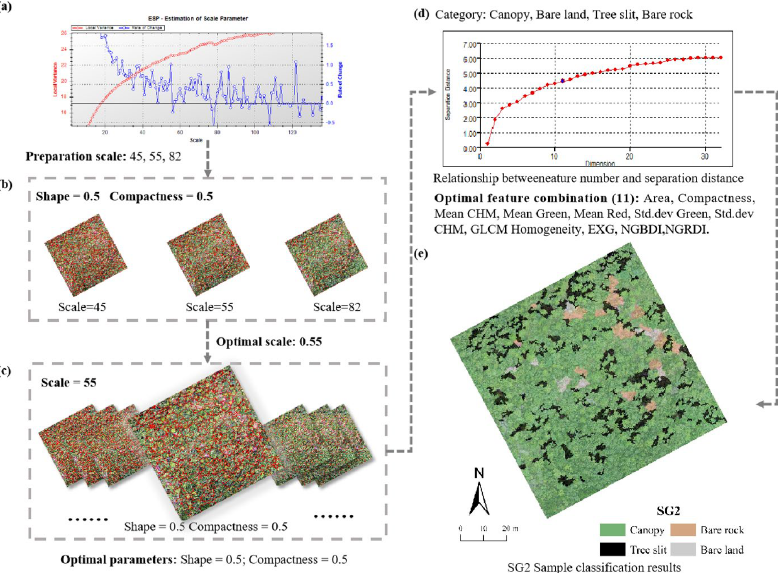
Figure A4. The process of extracting the canopy of sample SG2 based on object-oriented method. ( a ) The preparation scales were calculated using the ESP2 tool and obtained as 45, 55, 82; ( b ) The shape and compactness parameters were both set to 0.5 for comparison to obtain the optimal segmentation scale of 55; ( c ) The shape and compactness parameters are 0.5/0.5 when iterating through the shape and compactness parameters to obtain the best segmentation effect, respectively. ( d ) According to the relationship between feature number and separation distance choose to the optimal feature combination; ( e ) SG2 sample classification results.